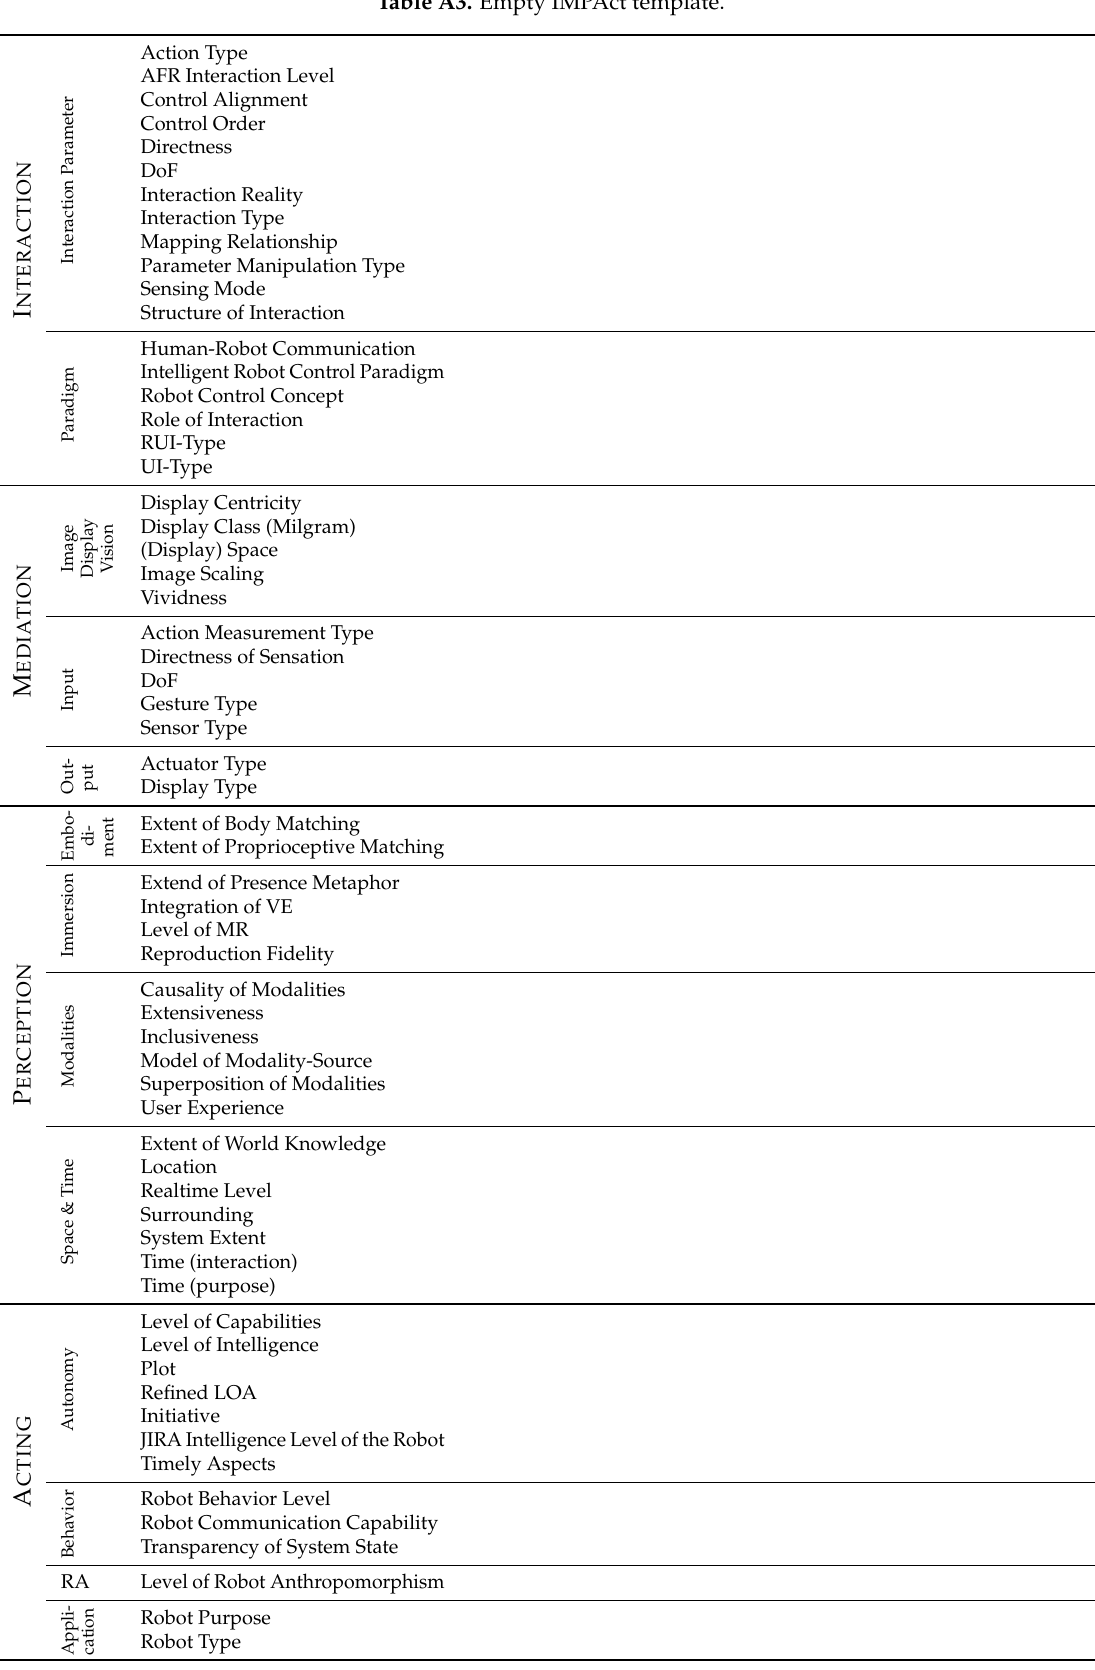
Table A3. Empty IMPAct